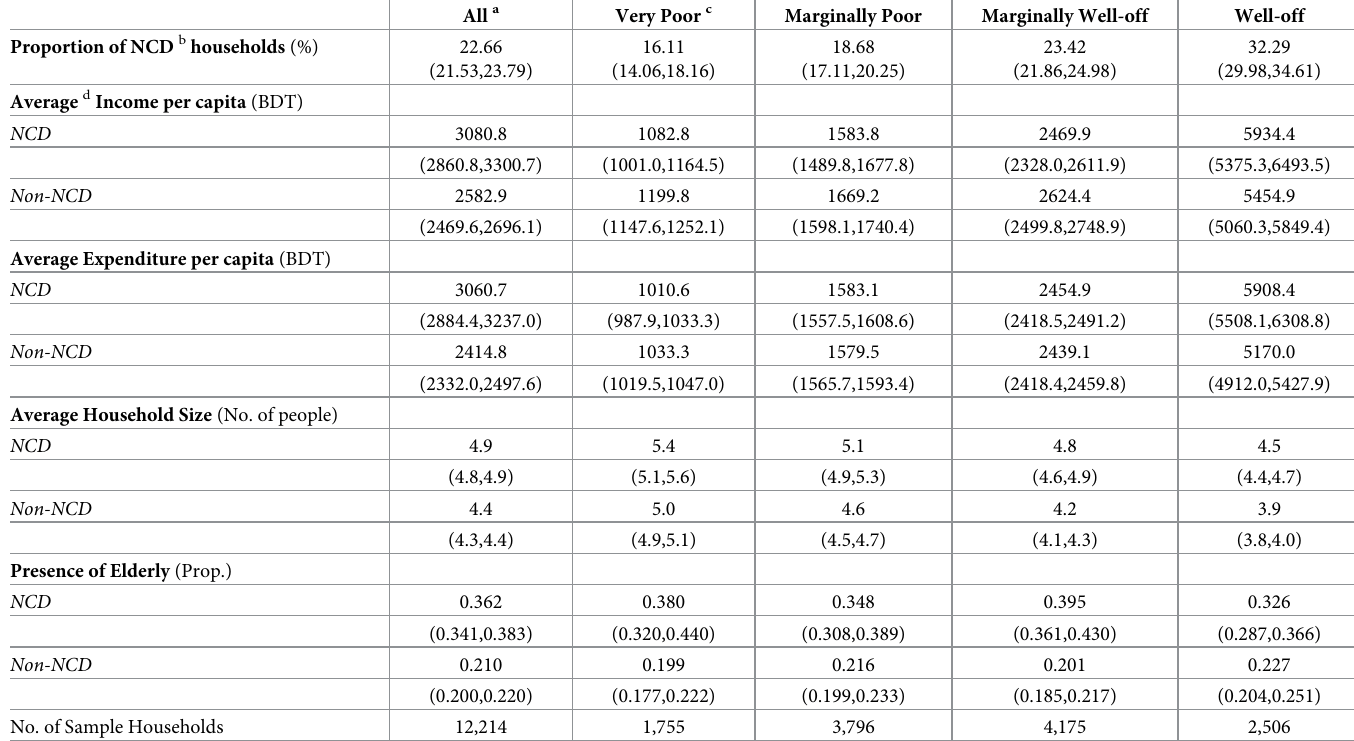
Table 1. Descriptive statistics.